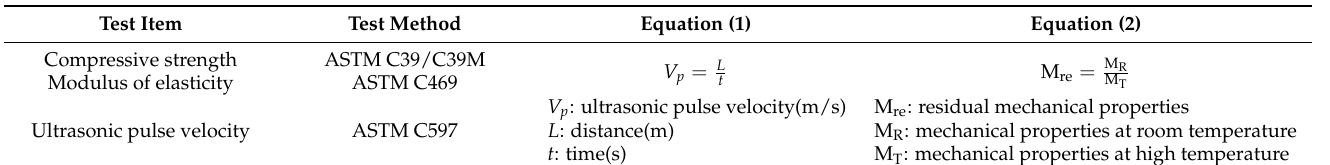
Figure 4. Heating curves. Table 5. Testing of residual mechanical properties.